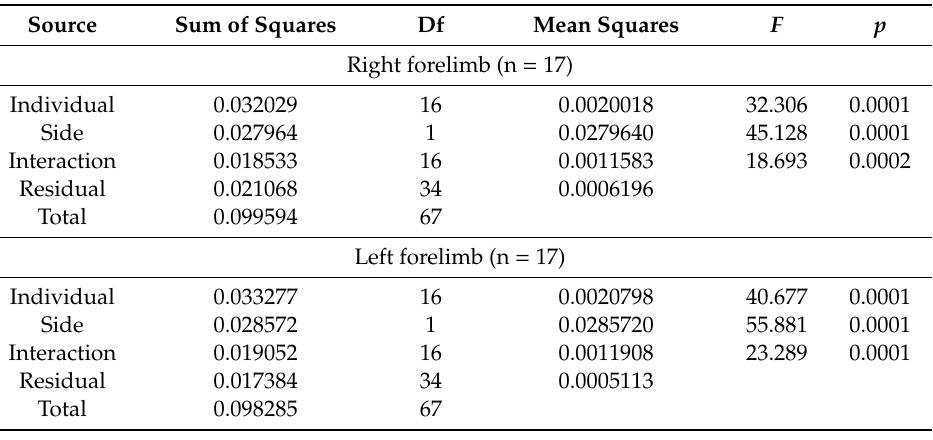
Table 1. Procrustes ANOVA for shape of right and left paired forelimbs of Pyrenean Brown calves (n = 17), with a significant “Side” (directional asymmetry) and interaction e ff ect (fluctuating asymmetry, 9999 permutation rounds). Sums of squares and mean squares are in units of Procrustes distances (dimensionless). The measurement errors showed that mean squares for interaction e ff ects exceeded the measurement errors. There appeared to be directional asymmetries and fluctuating asymmetries for both right and left forelimbs. Sums of squares and mean squares are in units of Procrustes distances